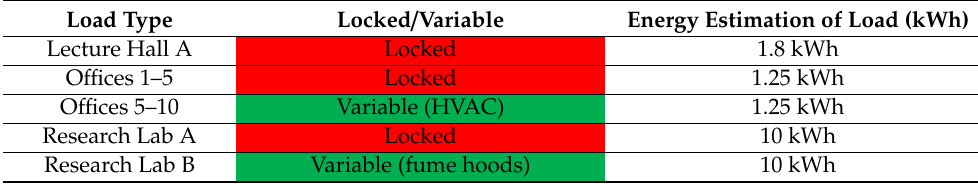
Table 1. Simplistic response of a departmental energy policy framework over a 0.5 h time-step (without campus IoT intervention).